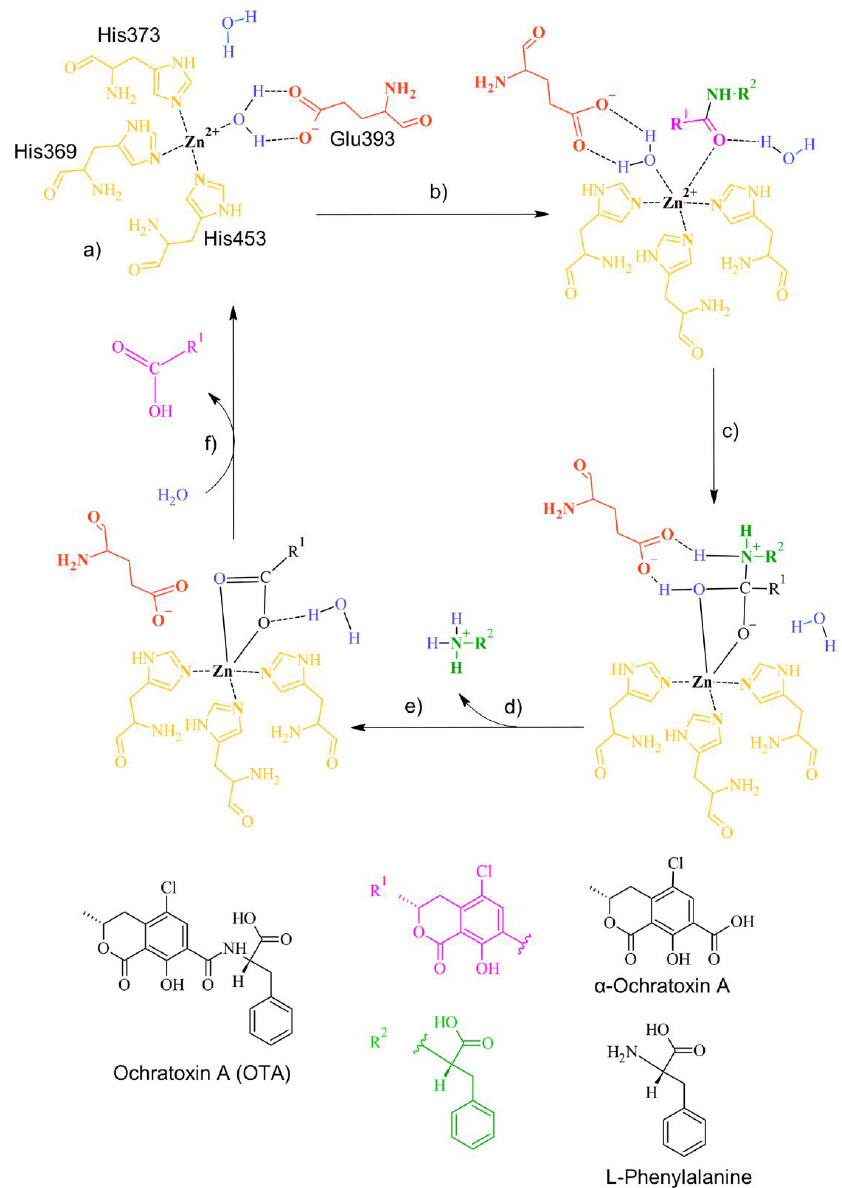
Figure 21. The detoxifying mechanism in OTA by neutral metalloendopeptidase. ( a ) Binding site of neutral metalloendopeptidase; ( b ) The carbonyl oxygen of OTA interacts with the Zn of the enzyme, forming a complex with a water molecule; ( c ) The complex between the water and the O of the carbonyl dissolves. A covalent bond between the O of the carbonyl and the Zn is formed. A complex between the O of the water molecule and the carbonyl of OTA is formed. A bond between the H of water and the amine group in OTA is formed; ( d ) The amine group is released; ( e ) The double bond of the carbonyl group with the O in OTA is restored. The interaction between glutamic acid and OTA is broken, and a complex between the water molecule and the O of OTA’s carbonyl is formed; ( f ) The carbonyl group is released, and the ingress of a water molecule restores the active site. Molecular dynamics showed that metalloendopeptidase – OTA complex maintained stable interactions throughout the 100 (ns; Table 4), despite OTA slightly moving from the In vitro experiments showed differences in the neutral metalloendopeptidase capacity to reduce OTA at different pH conditions (ANOVA p ≤ 0.0001; F = 464; Figure 23). Sidak’s multiple comparisons tests showed differences between the control and all tested pH’s treatments, at pH 4.6 in 8.2% ( p ≤ 0.0001; t = 7.07; DF = 12); at pH 5 in 14.44% ( p ≤ 0.0001; t = 12.47; DF = 12); at pH 7 in 45.26% ( p ≤ 0.0001; t = 39.08; DF 12). The final product was identified unequivocally as α -ochratoxin (Figure